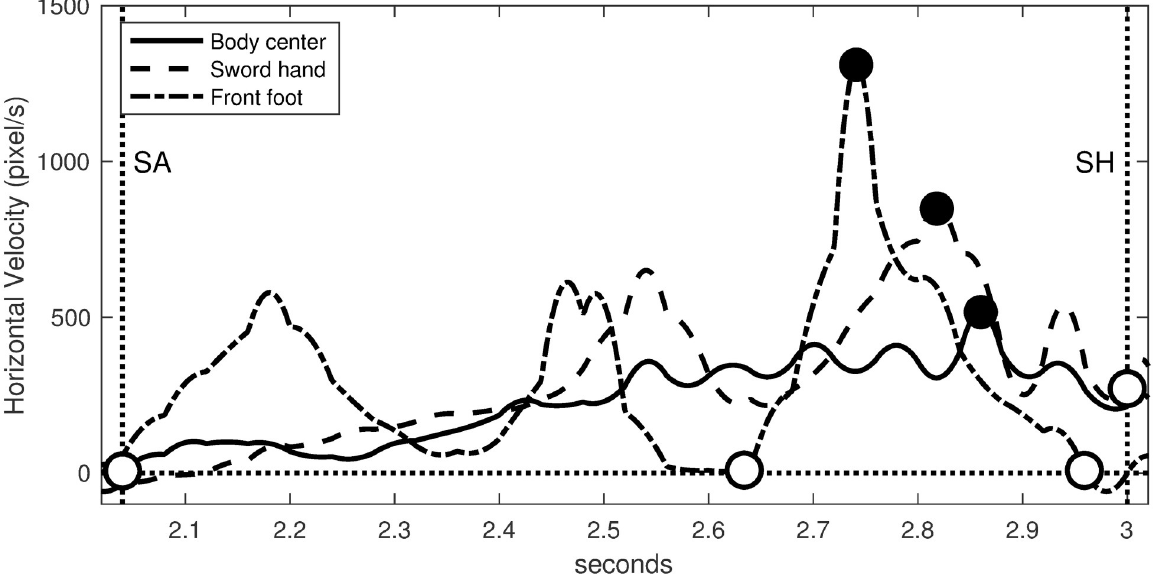
Fig 20. Characterization of Steffen’s lunge attack. Horizontal velocities are measured at the body center (solid line), sword hand (dashed line) and front foot (dash-dot line). Decisive movements are delimited by black dots (maximum velocity peaks) and white dots.